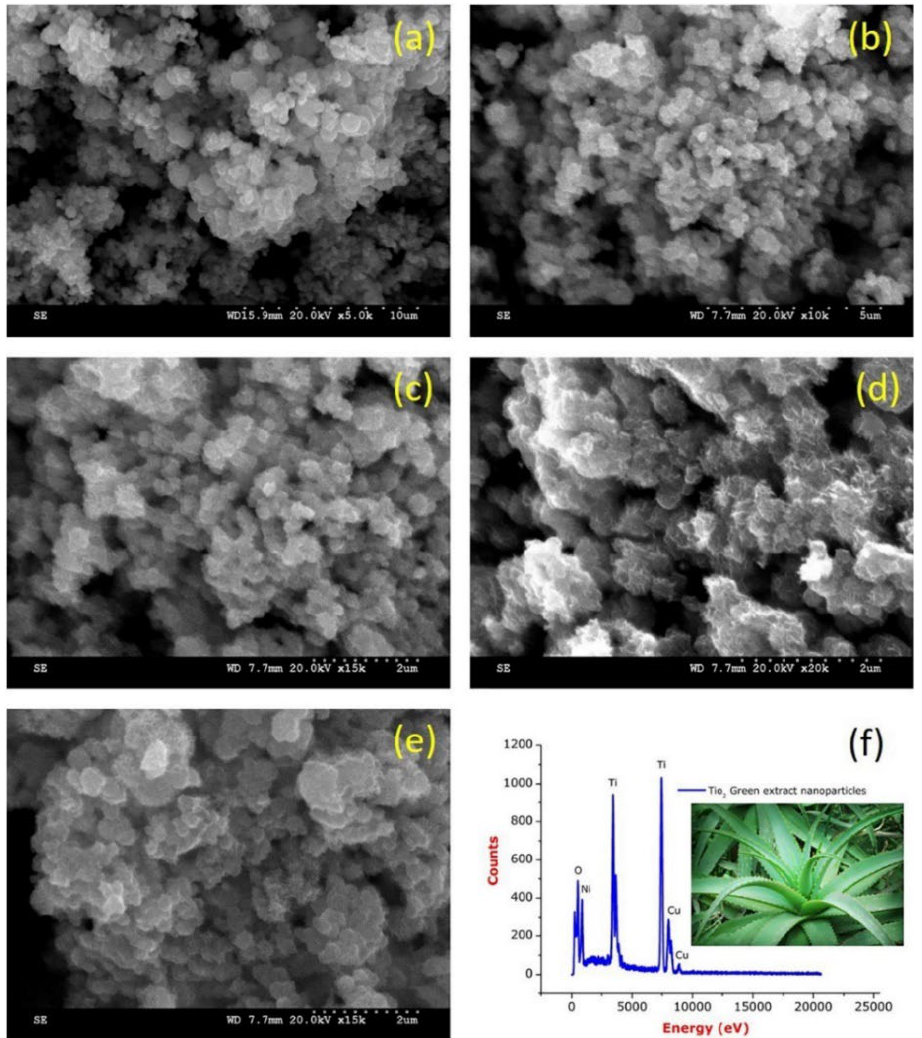
Figure 17. ( a – e ) FESEM images of TiO 2 -NPs and ( f ) EDS spectrum of TiO 2 -NPs. Reprinted from [65].